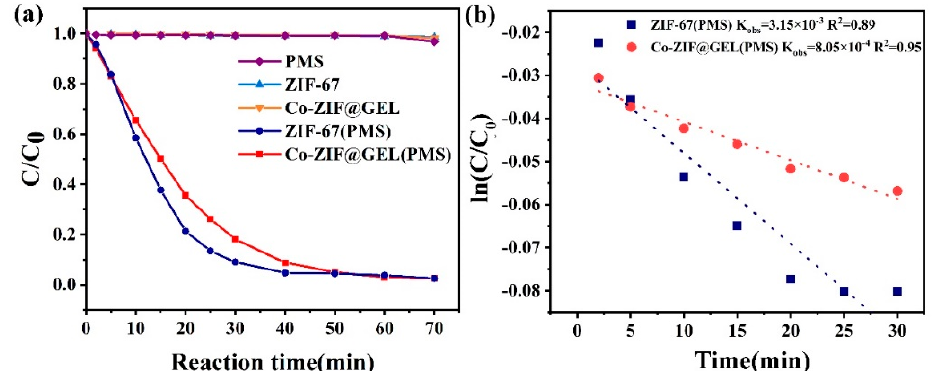
Figure 4. ZIF-67, Co-ZIF@GEL, PNP degradation performance under the peroxymonosulfate (PMS) system. ( a ) The result of composite aerogel catalytic degradation ability on PNP; ( b ) the effect of cellulose inclusion on the catalytic active site. (conditions: PNP=10mg/L, PMS=1mM, ZIF-67=50mg/L, Co-ZIF@GEL=100mg/L, GEL=100mg/L, PH=6.8, T=25 ℃ ).